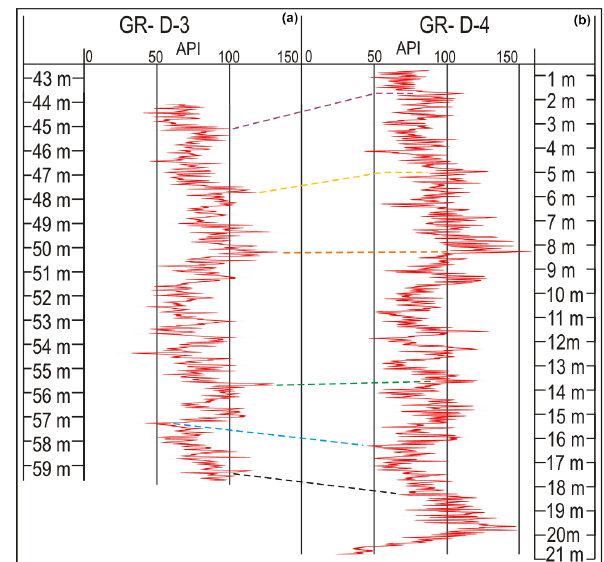
Figure 4. Correlation of gamma-ray logs from the (a) D-3 (metre 44 downwards) and and (b) D-4 (metre 1–21) drillings.